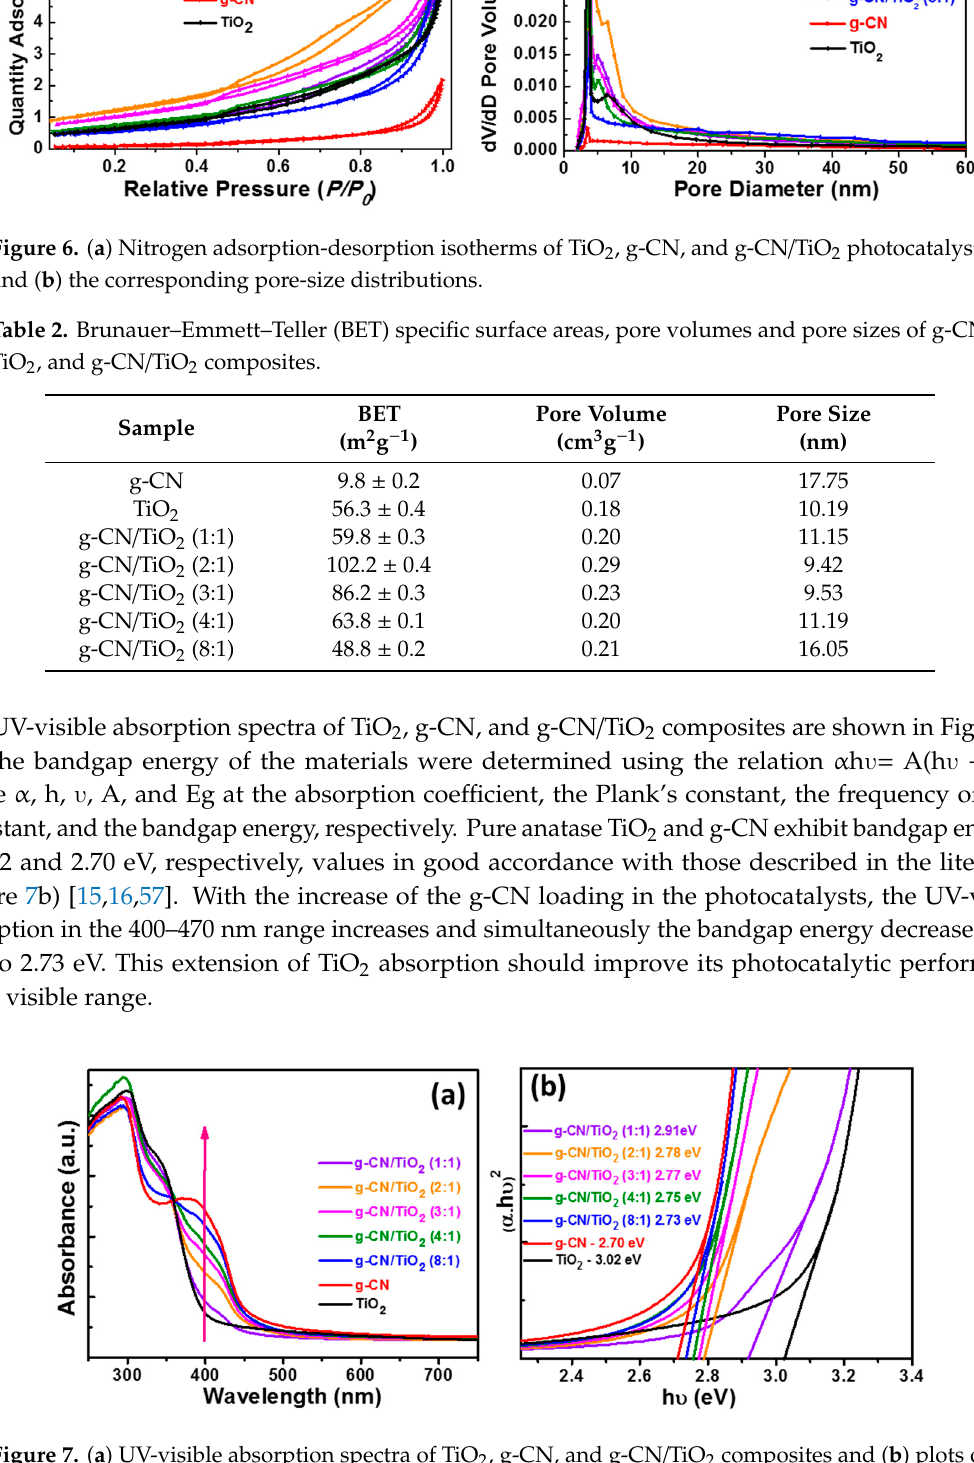
Figure 7. ( a ) UV-visible absorption spectra of TiO 2 , g-CN, and g-CN/TiO 2 composites and ( b ) plots of ( α h γ ) 2 vs h γ used to determine the energy bandgap of the